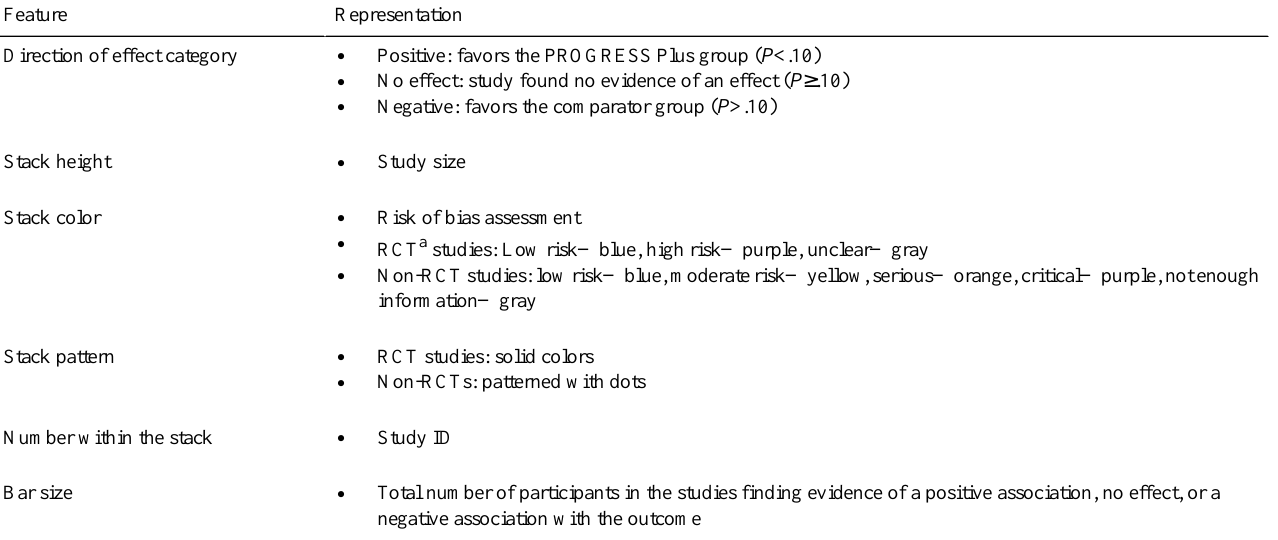
Table 1. Key to the Adapted Harvest